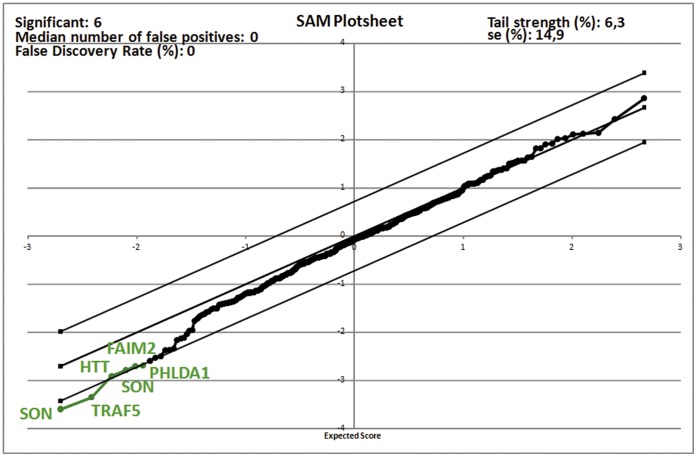
Analysis of genes significantly associated to the cell viability index as determined by the Significance Analysis of Microarray (SAM) software.All significant genes are represented in green color on the plot.